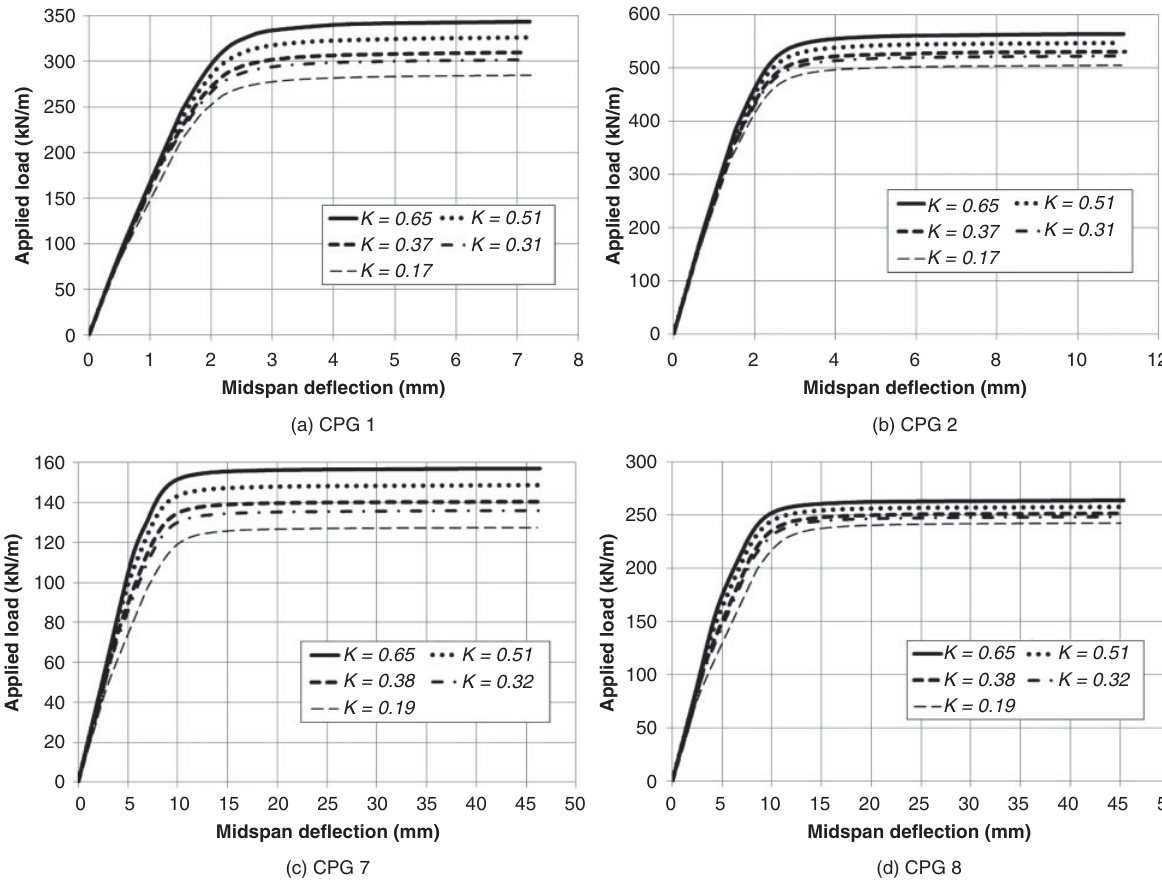
Fig. 8. Behaviour of girders under uniformly distributed load: (a) CPG 1; (b) CPG 2; (c) CPG 7; (d) CPG 8